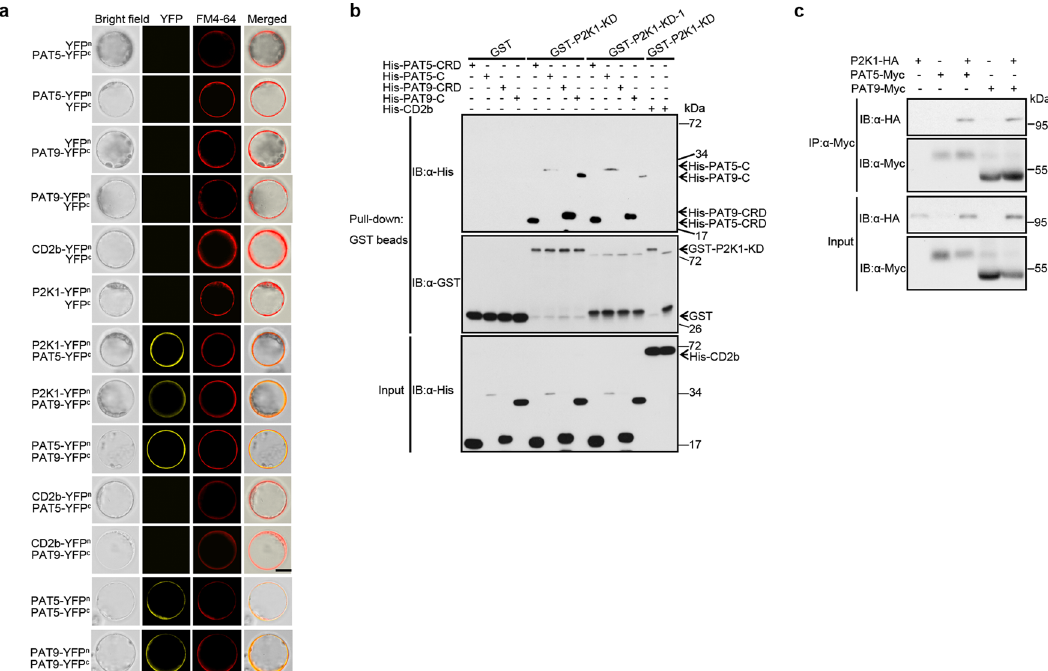
Fig. 2 PAT5 and PAT9 directly interact with P2K1 in vitro and in vivo. a Interactions of PATs and P2K1 receptor at Arabidopsis protoplast plasma membrane. FM4-64 was used to stain the plasma membrane. Bar = 20 μ m. b Directly interaction of PATs and P2K1 in vitro. Puri fi ed, recombinant proteins were incubated with Glutathione Sepharose 4B beads followed by GST-His pull-down assay. His-CD2b (At5g09390, CD2-binding protein-related, a substrate of P2K1 from KiC assay data) was used as a negative control. c PAT5 and PAT9 interact with P2K1 in vivo. The indicated constructs were transiently expressed in Arabidopsis wild-type protoplasts followed by Co-IP assays. All experiments were performed and analyzed three times with similar